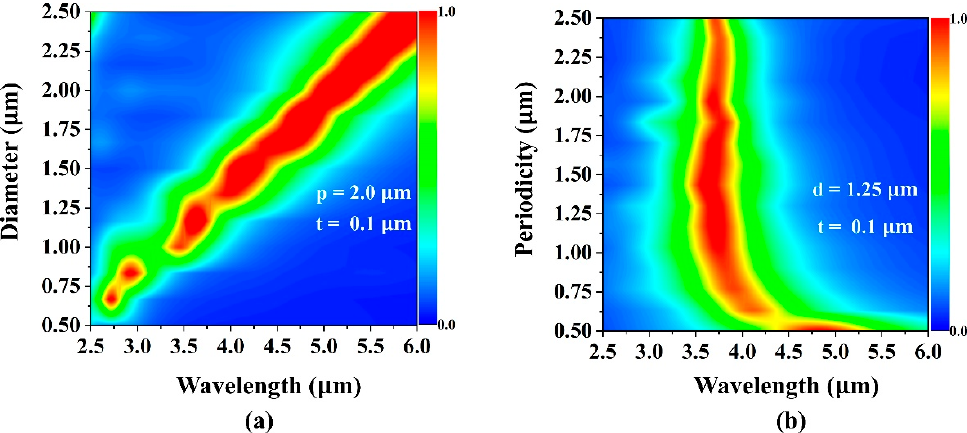
Figure 3. ( a ) The periodicity dependence with p changed from 0.5 to 2.5 µ m while keeping the diameter and insulator thickness unchanged at 1.25 µ m and 0.1 µ m, respectively. ( b ) The diameter dependence with d changed from 0.5 to 2.5 µ m, while keeping the periodicity and insulator thickness unchanged at 2.0 µ m and 0.1 µ m, respectively.